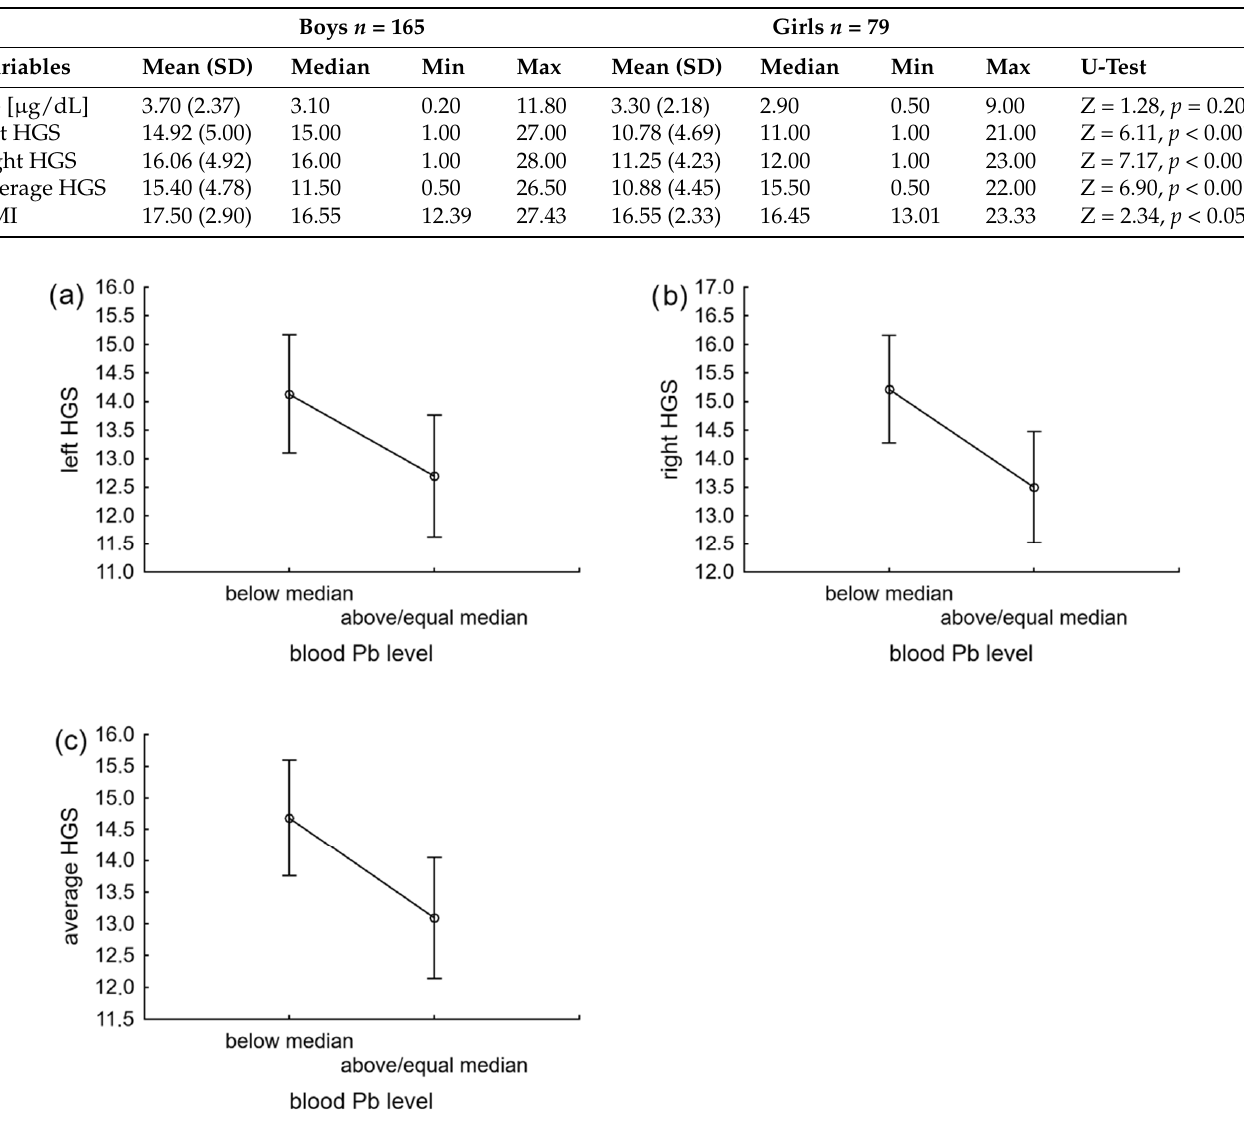
Figure 1. Differences in ( a ) left, ( b ) right and ( c ) average HGS (means and CI) between blood lead level groups (below or equal and above the median value = 3.10 µg/dl). All children with blood lead level below the group median had a significantly higher level of strength of the left and right hands as well as average HGS, irrespective of sex.